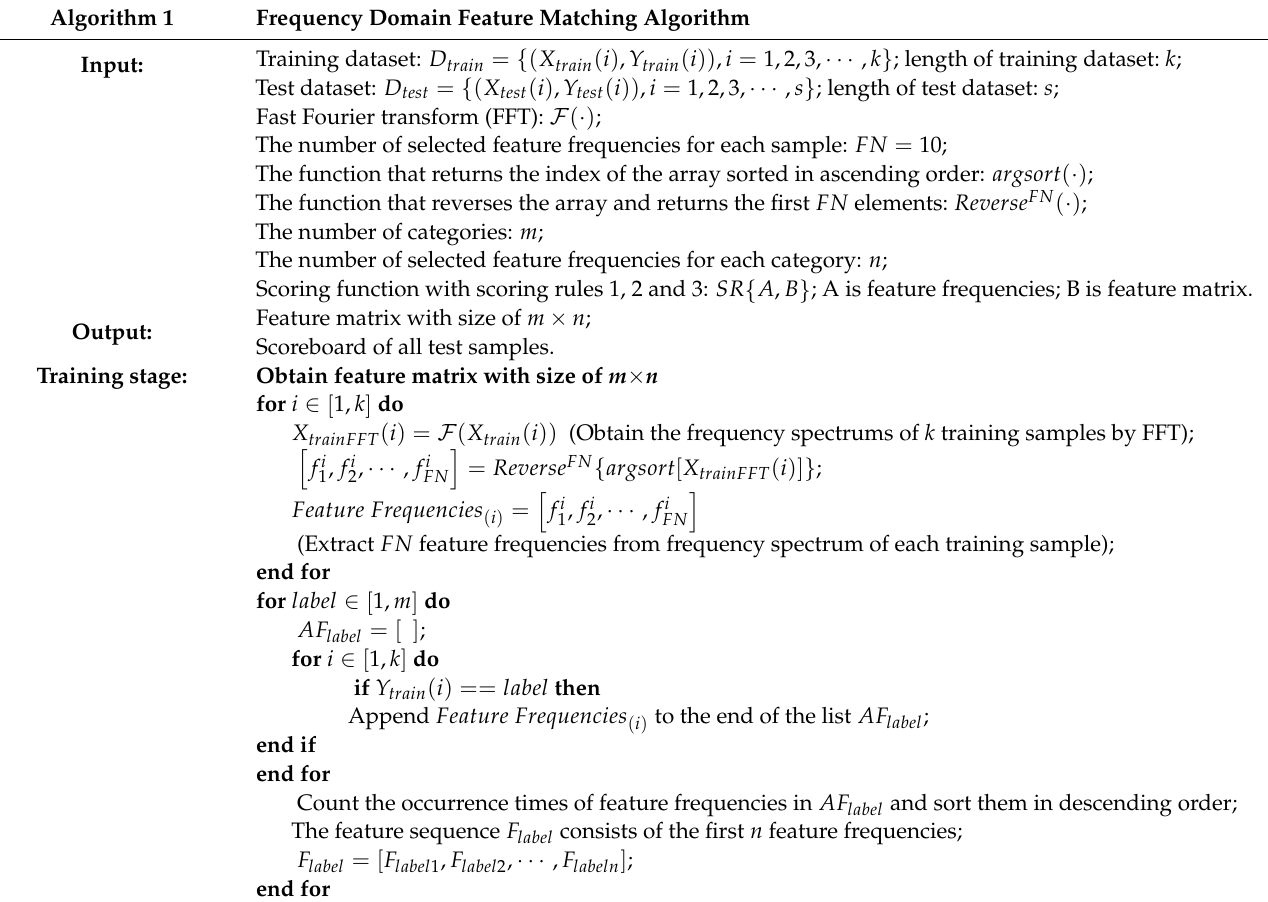
Algorithm 1 Frequency Domain Feature Matching